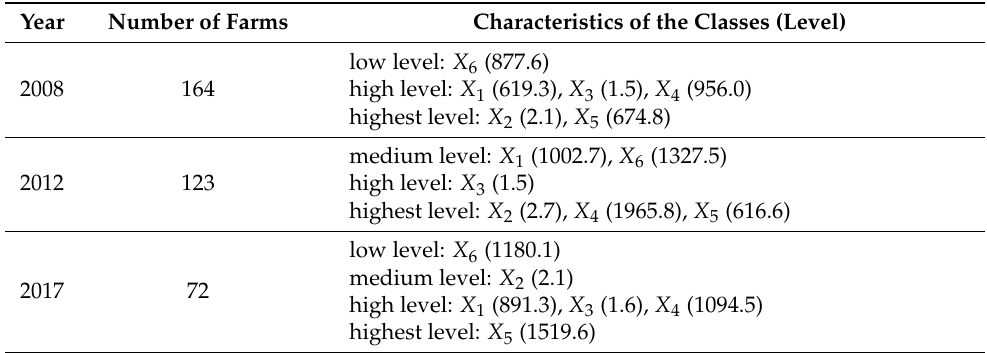
Table 6. Characteristics of farms in the type three group.